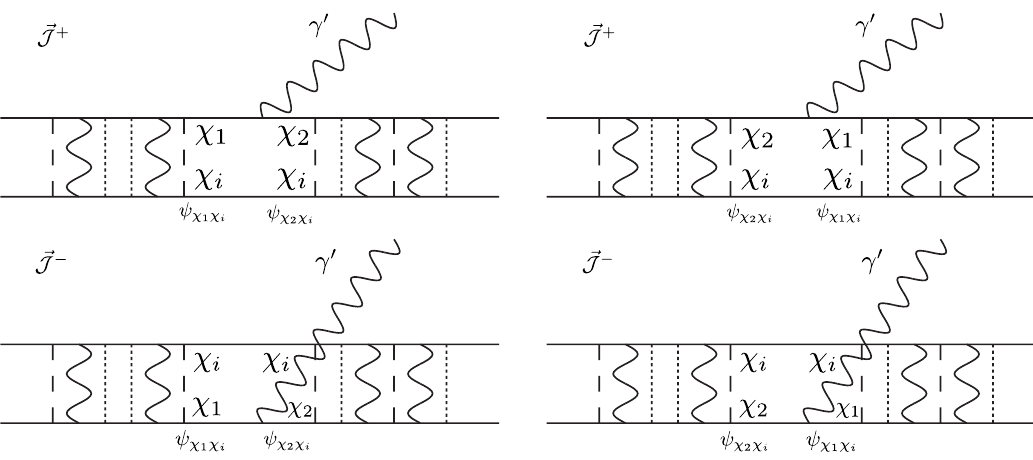
Figure 4 . Sketch diagrams emitting a (cid:13) 0 . All the coupling signs are the same, but ~ J + will induce a cross relation between the components of the s and d